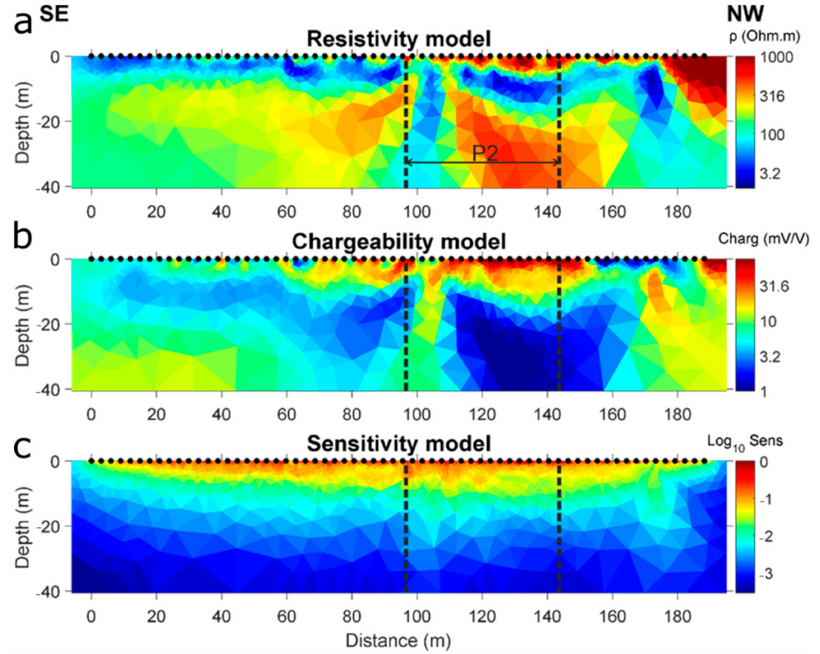
Figure 4. Inversion results for P1: ( a ) electrical resistivity model, ( b ) chargeability model and ( c ) normalized sensitivity model. The electrodes are represented by black circles. The extent of the second profile (P2) is shown by the dashed lines. Charg—Chargeability, Sens—Sensitivity.